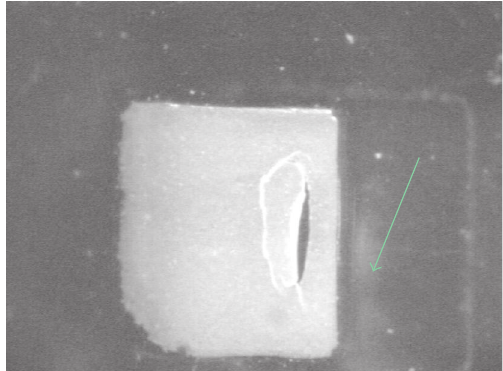
Figure 7: PVP film surface after laser treatment ( F = 1 . 7J/cm 2 , 60 pulses). Green arrow indicates a material ejection; black area repre- sents nonirradiated region of PVP film. On the right in the irradi- ated spot, the surface ruptures are